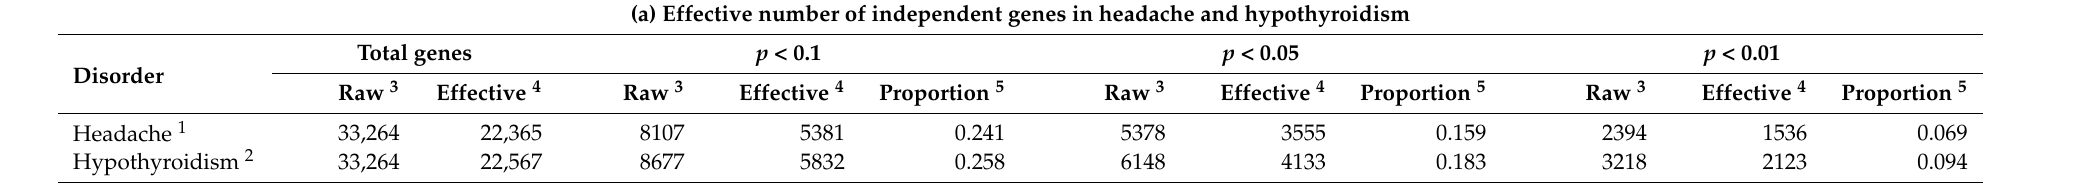
(b) Number of overlapping genes and binomial test p -value for gene-level genetic